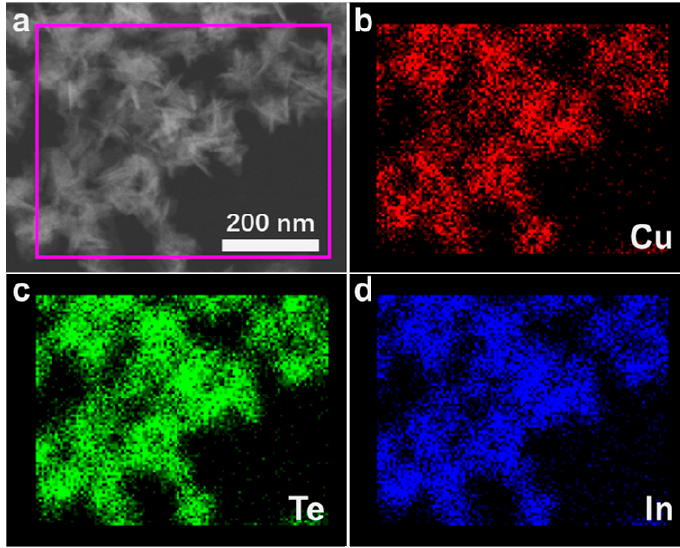
Figure 5. Scanning transmission electron microscopy (STEM) and energy-dispersive X-ray (EDX) elemental mapping of Cu, In, and Te of CuInTe 2 nanocrystals (4 mmol stearic acid).